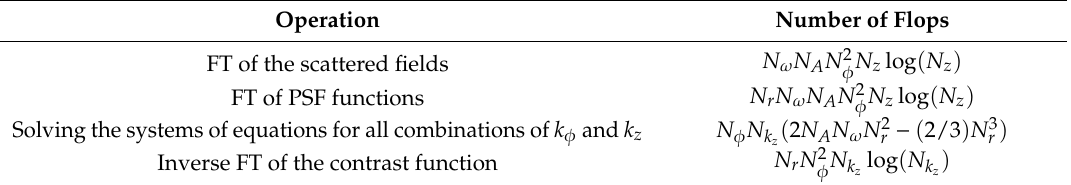
Table 3. Details of computational complexity of the proposed image reconstruction